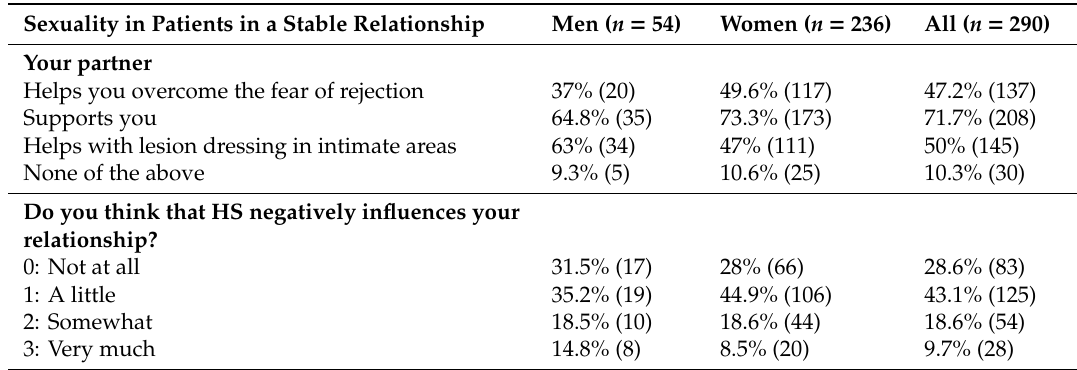
Table 4. Sexuality in patients with HS in a stable